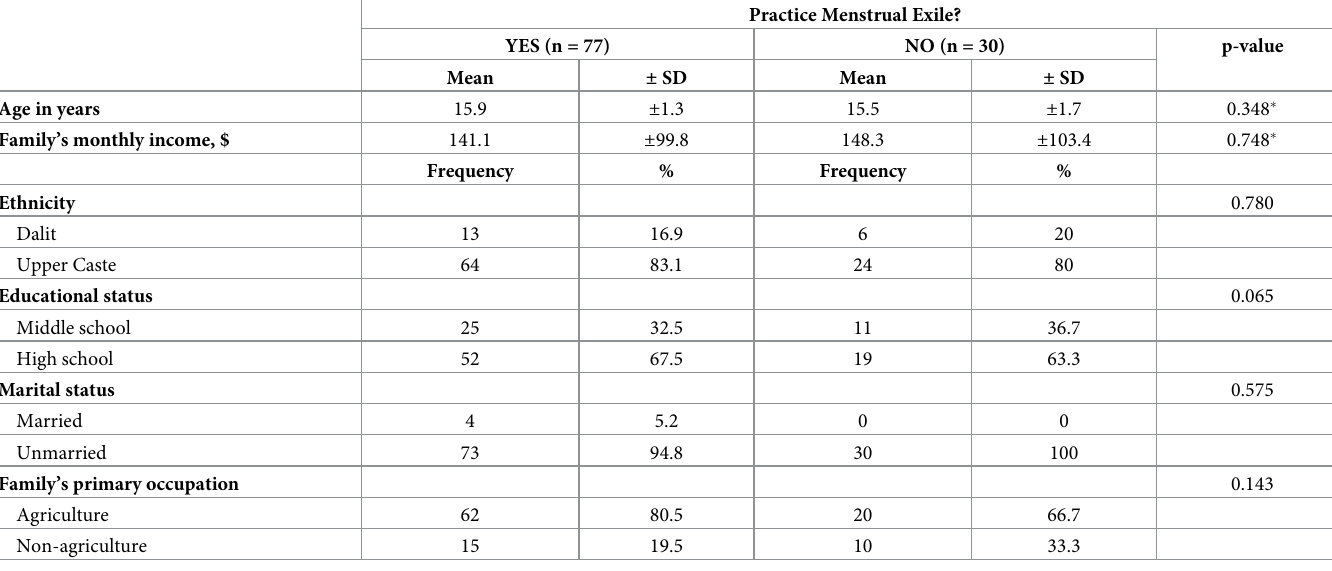
Table 1. Demographic characteristics of 107 study participants by menstrual exile